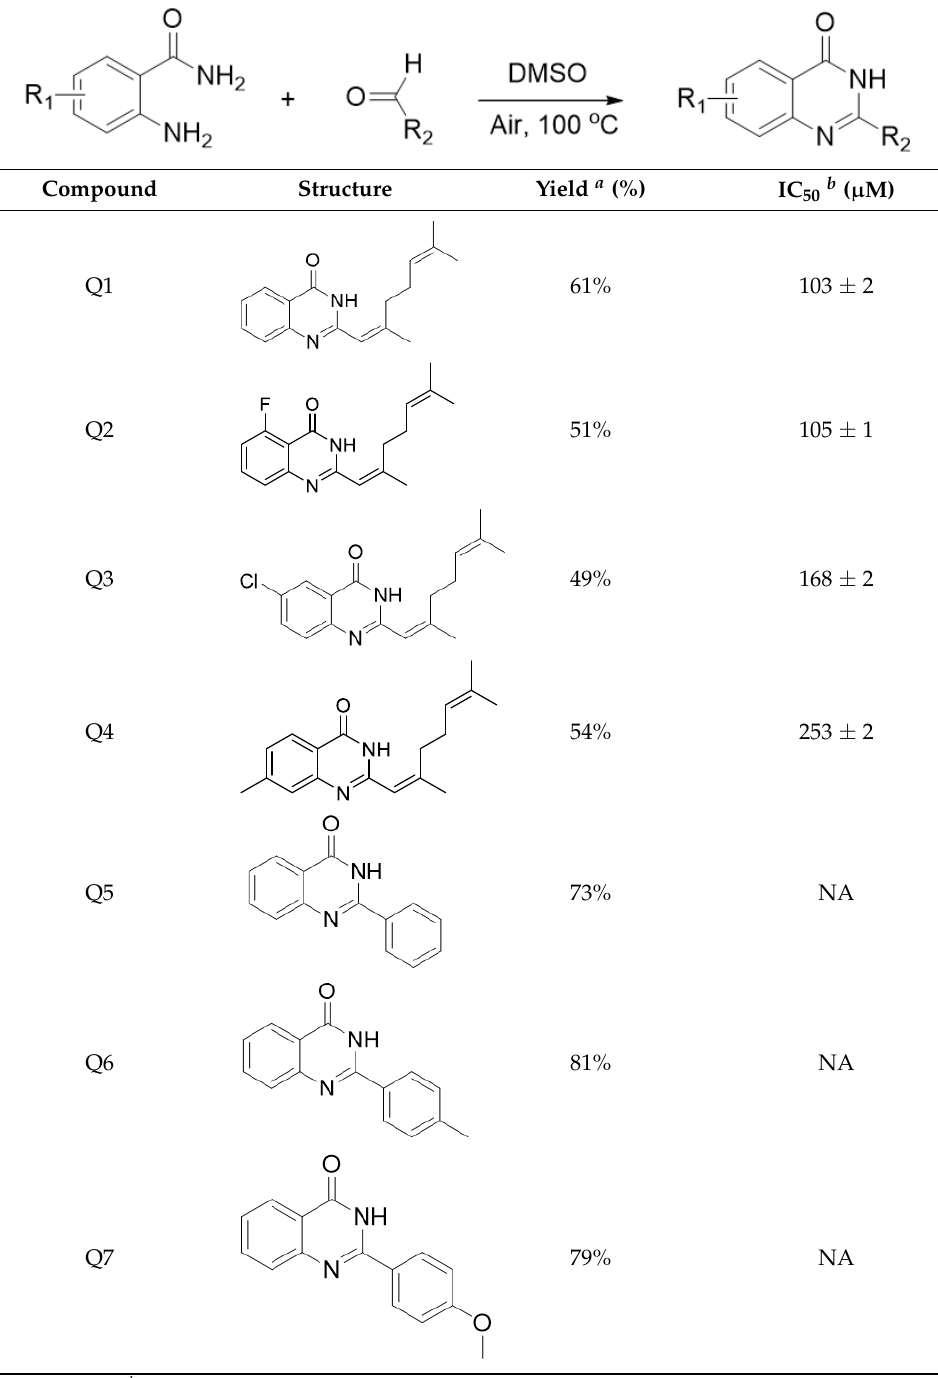
a Isolated yields. b Values are expressed as mean of triplicate determinations ± standard deviation.